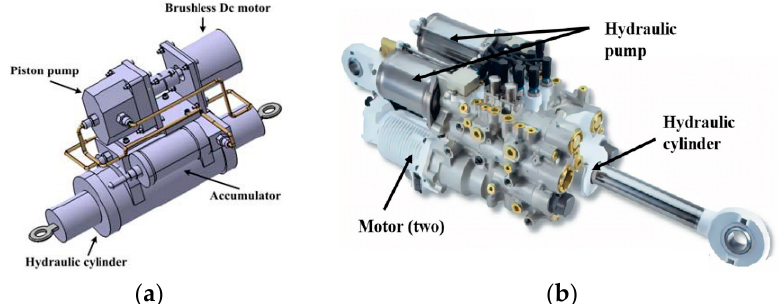
Figure 5. EHA with different redundancy. ( a ) Single redundancy EHA physical prototype. Reprinted with permission from Ref. [9]. 2014, Elsevier; ( b ) Double redundancy EHA physical prototype applied on F-35. Reprinted with permission from Ref. [10]. 2019, AIAA.